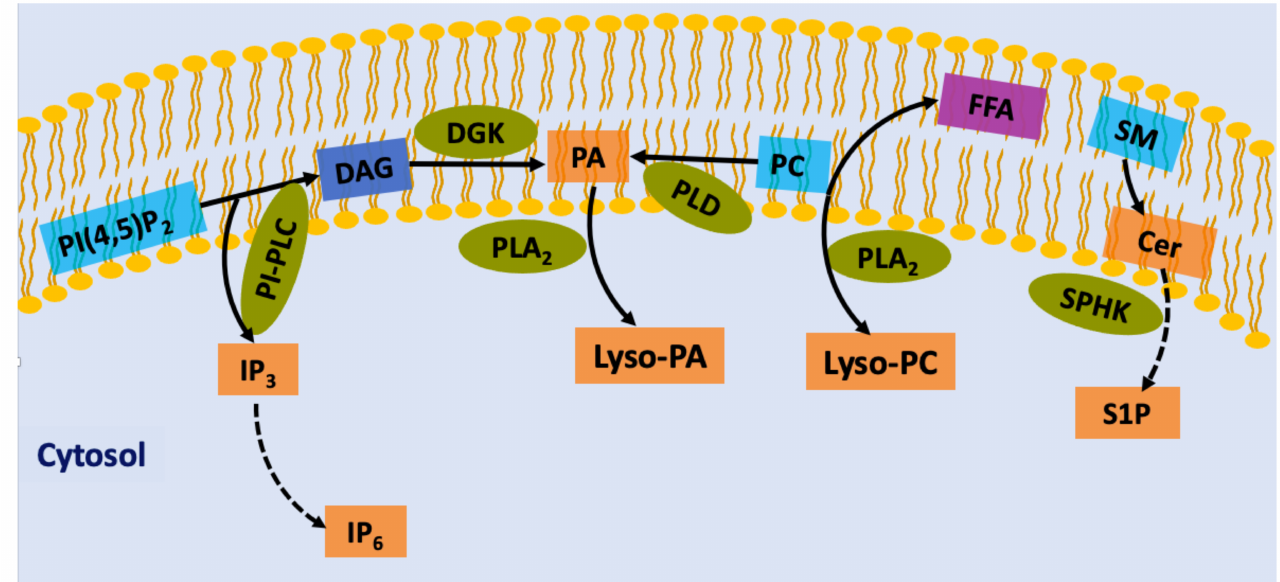
Figure 1. Generation of lipid second messengers in plants. Phospholipid precursors (blue box) involved in the production of intracellular second messengers (orange box). PI-PLC leads to the cleavage of PIP 2 into DAG and IP 3 . DGK converts DAG to PA, which is a second messenger on its own right. PA, which can also be generated by PC hydrolysis by PLD. DAG can also be synthesized from PC via PLD. IP 3 diffuses into the cytosol, where it is converted to IP 6 . Fatty acids of phospholipids are liberated by PLA2s and converted to eicosanoids. Lysophospholipids are also precursors of a different class of lipid mediators, including Lyso-PC or Lyso-PA. Sphingomyelin is a precursor of ceramide that can then be phosphorylated to generate ceramide 1-phosphate and to form sphingosine, which is phosphorylated to generate sphingosine 1-phosphate. PIP 2 , phosphatidylinositol (4,5)-bisphosphate; PC, phosphatidylcholine; PI-PLC, phosphoinositide-phospholipase C; IP 3 , inositol (1,4,5)-trisphosphate; IP 6 , myo-inositol-1,2,3,4,5,6 hexaskisphosphate; DAG, diacylglycerol; PLD, phospholipase D; PA, phosphatidic acid; PLA2, phospholipase A2; Lyso-PA, lyso-phosphatidic acid; Lyso-PC, lyso-phosphatidylcholine; FFA, Free Fatty Acid; SM, sphingomyelin; Cer, ceramide; SPHK, sphingosine kinase; S1P,